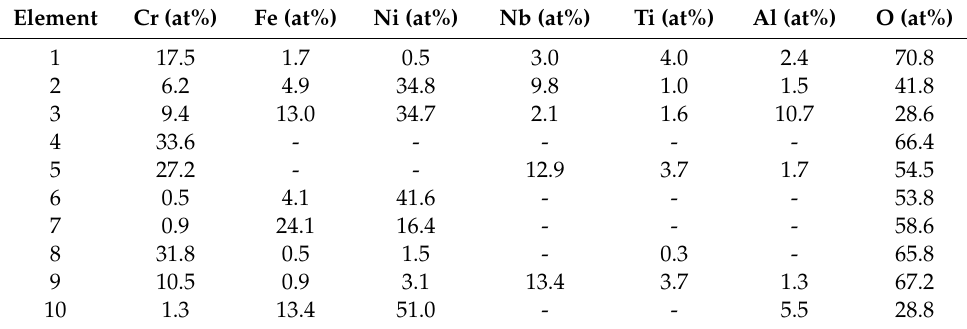
Table 3. The EDS results of points shown in Figure